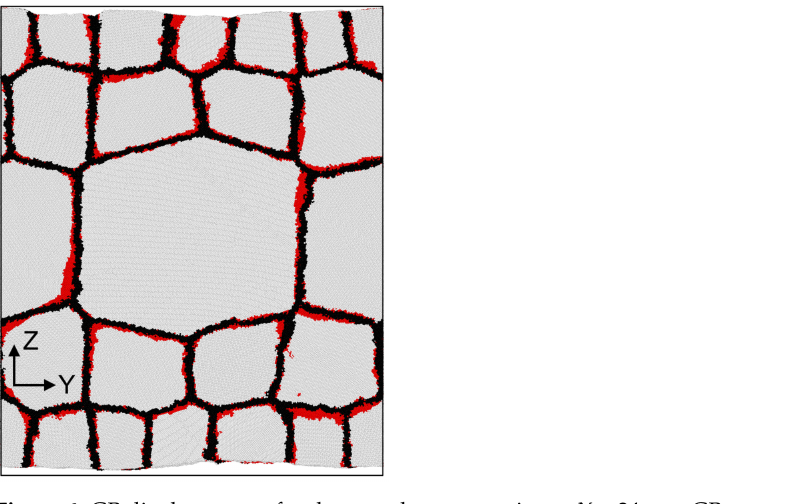
Figure 6. GB displacements for the sample cross section at X = 24 nm. GB atoms at 0% deformation are shown in black. Atoms involved in GB displacements during stretching to 20% are in red.